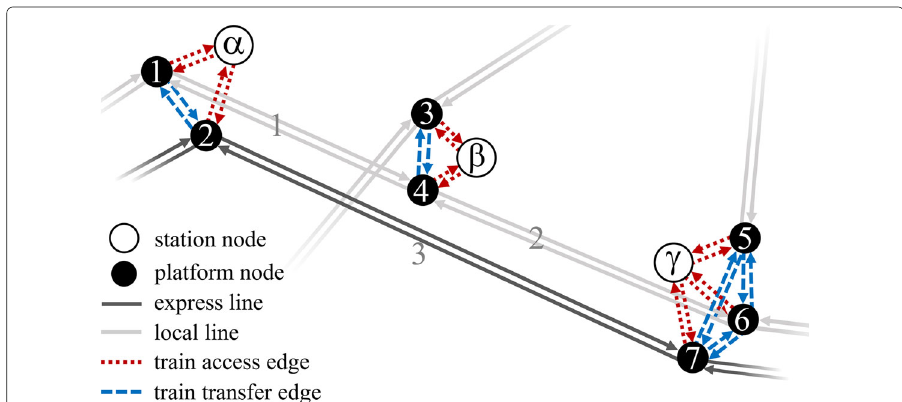
Fig. 3 Simplified example of the directed train network construction. Station nodes α , β , and γ represent the physical stations and dotted red links represent access links that connect the station to each platform. Each type of train on each train route is represented by a separate platform node (black nodes 1 − − 7) which are connected to other lines at the same station by dashed blue transfer edges. Platforms are also connected to platforms of the same line at other stations by train route edges (gray). In this stylized example, lines 1 + 2 and 3 both use stations α and γ , but line 3 represents an express train that uses the same tracks without stopping at station β . Only the station nodes are connected to nodes of the other transportation networks.